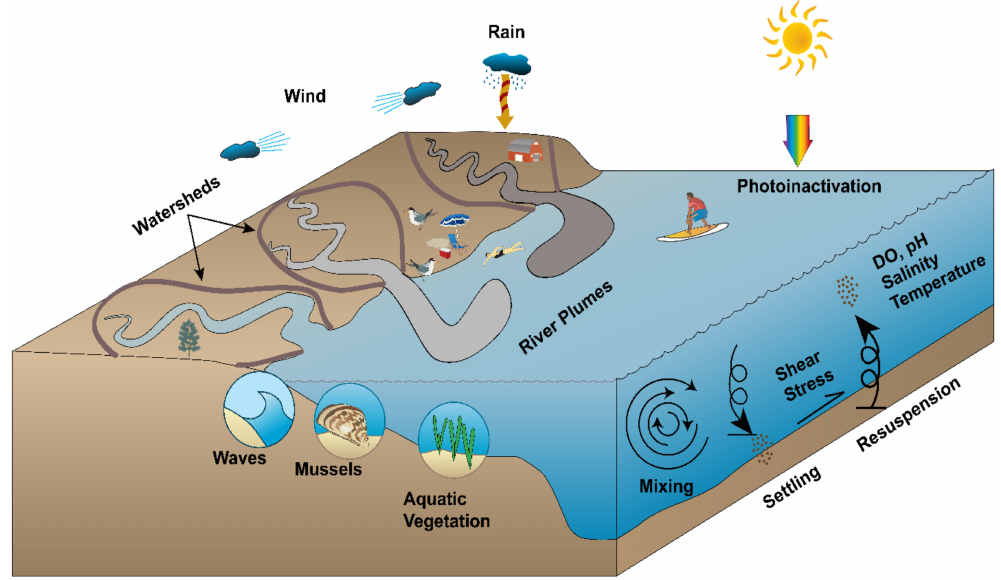
Figure 1. Complex factors influencing fecal indicator organisms (FIO) fate and transport at river-impacted nearshore